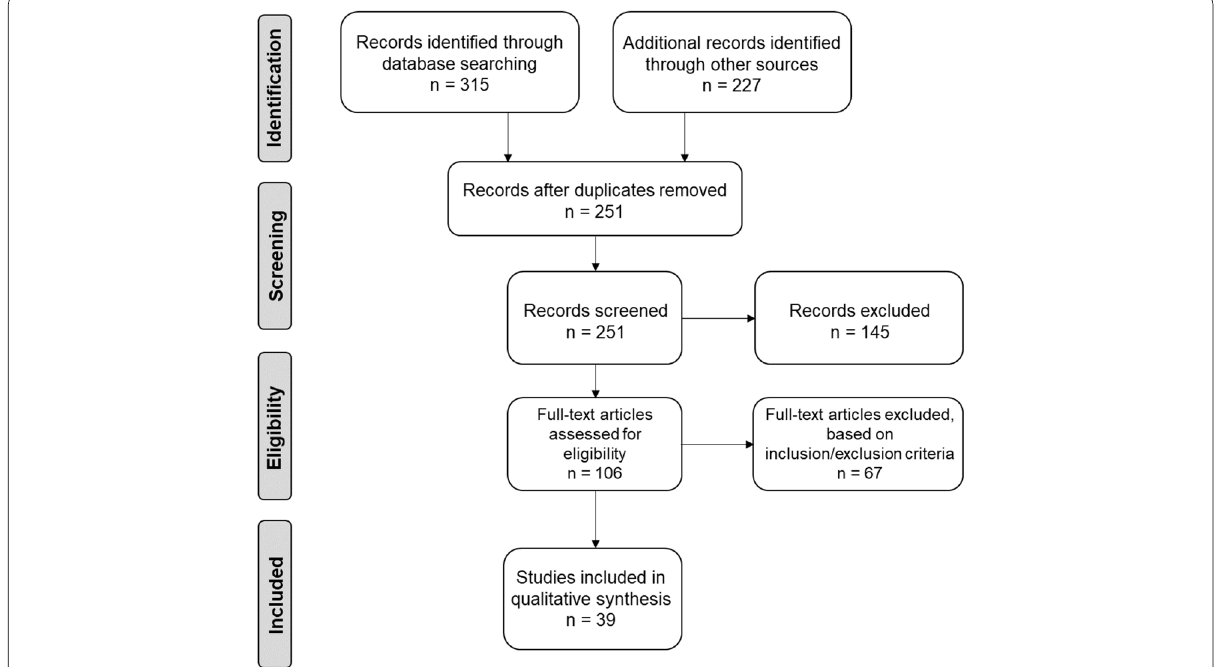
Fig. 1 PRISMA flow diagram displaying the search